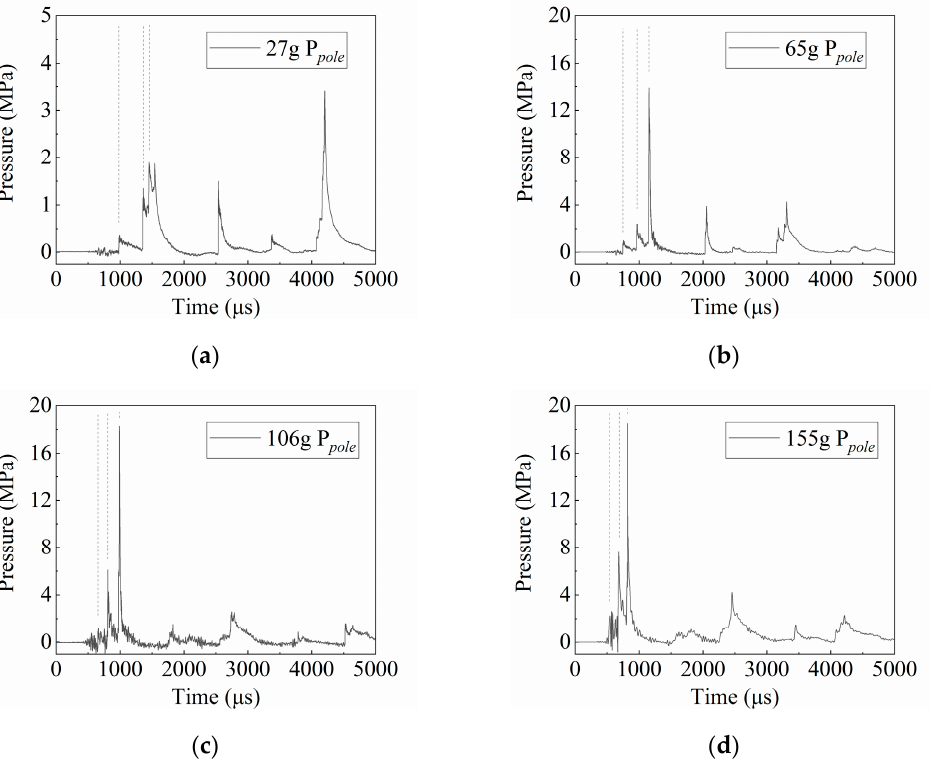
Figure 2. Time history curves of the pressure loading at poles of the different TNT charges: ( a ) 27g; ( b ) 65g; ( c ) 106g and ( d ) 155g. The dotted lines indicate the three peaks of the initial pressure stage.